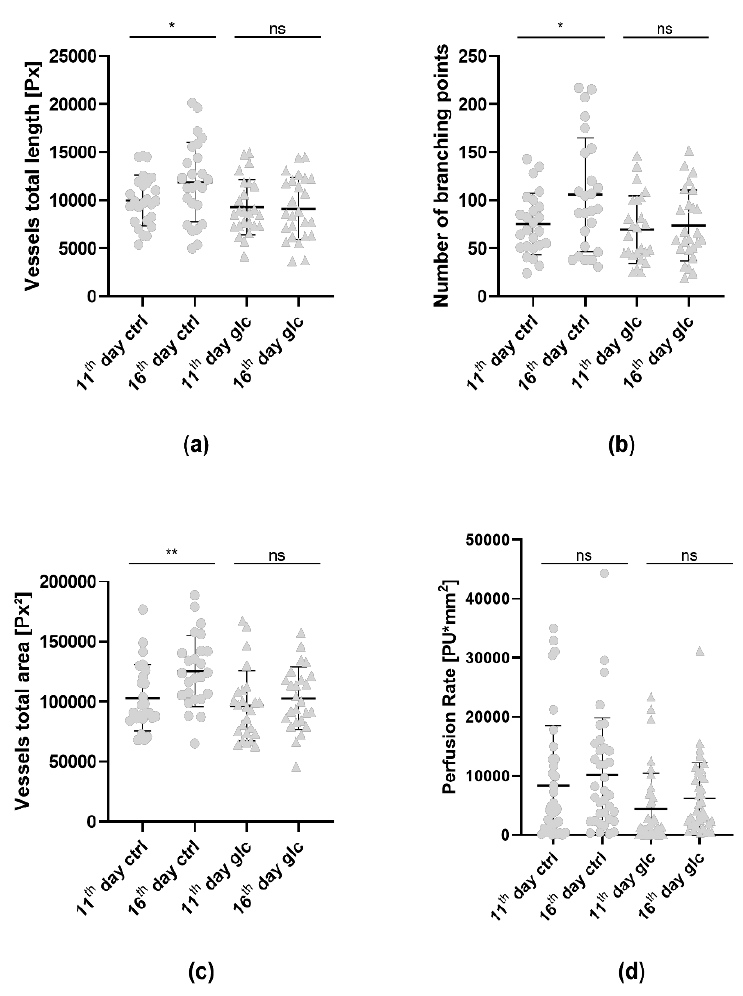
Figure 7. Graphs depicting the angiogenic development of the AS-M cell line tumors on the CAM measured with LSCI and the CAM assay application. Mean and standard deviation are included. ( a ) Length of all vessels, ( b ) number of branching points and ( c ) area of all vessels as measured by the CAM assay application version 3.0.0 from the IKOSA platform (ctrl, n = 25; glc, n = 25). ( d )